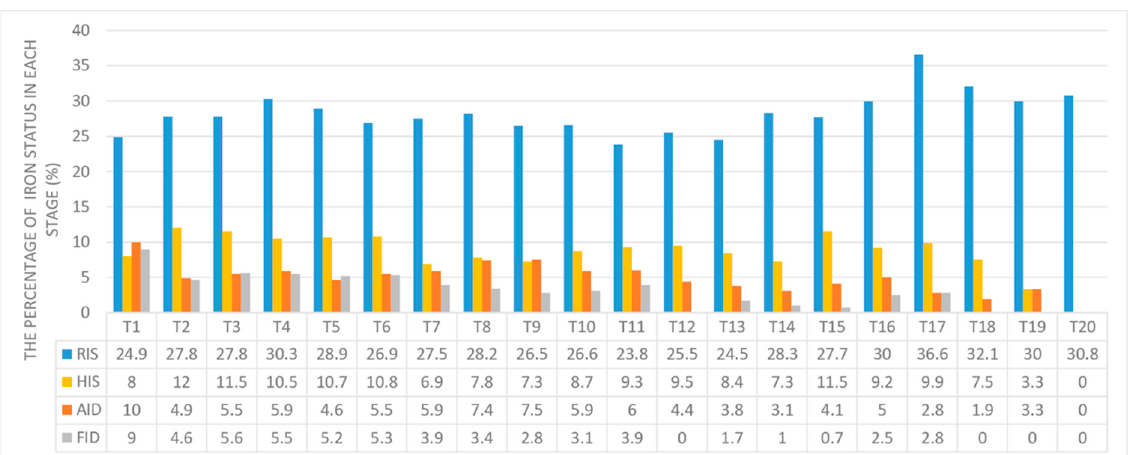
Figure 3. The distribution of iron status records at each follow-up phase. Table 2. Univariate and multivariate GEE analysis of longitudinal iron status and the episodes of peritonitis in PD patients.